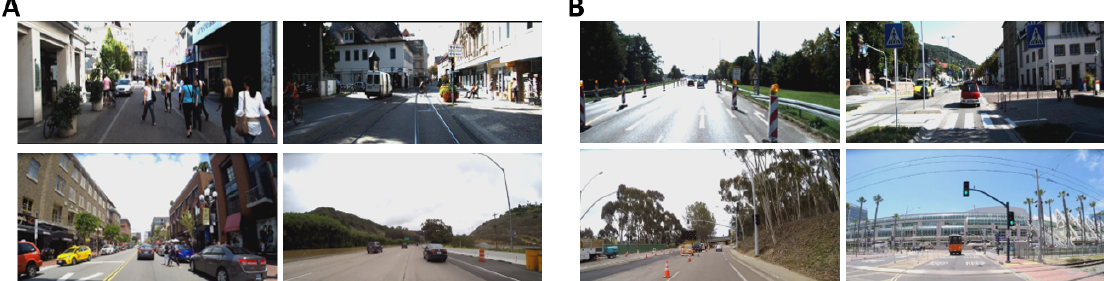
Figure 7. ( A ) Examples of 2-seconds incidents classified as hazardous. Examples include pedestrians crossing the street without a crosswalk while the ego vehicle is being driven and another vehicle overtaking suddenly. ( B ) Examples of 2-seconds incidents classified as non-hazardous. Examples include stop signs and railway crossing signs. For each category, the top images are from KITTI dataset whereas the bottom images are from LISA